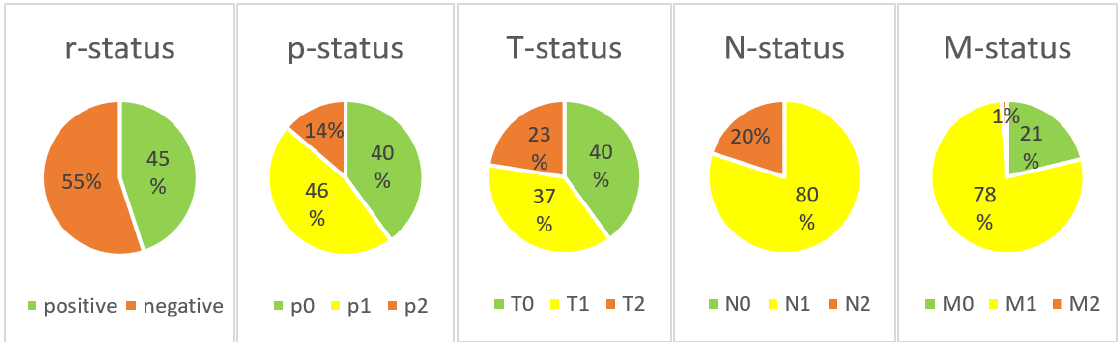
Figure 4. Distribution of subtypes according to the modified PJI-pTNM classification in our patient cohort.